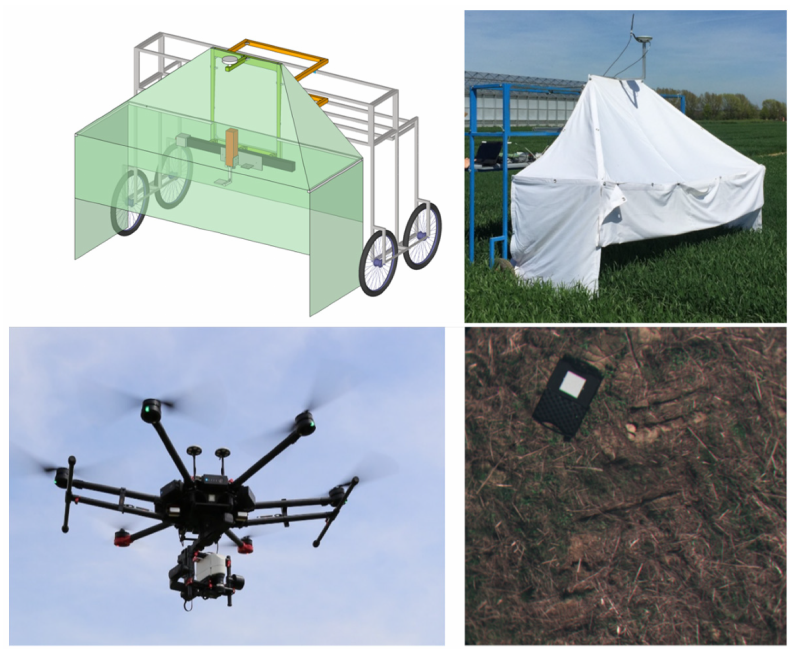
Figure 2. UAV system and photo-bike used for hyperspectral imaging of wheat farms [61]. Summary of various wheat leaf disease datasets is presented in Table